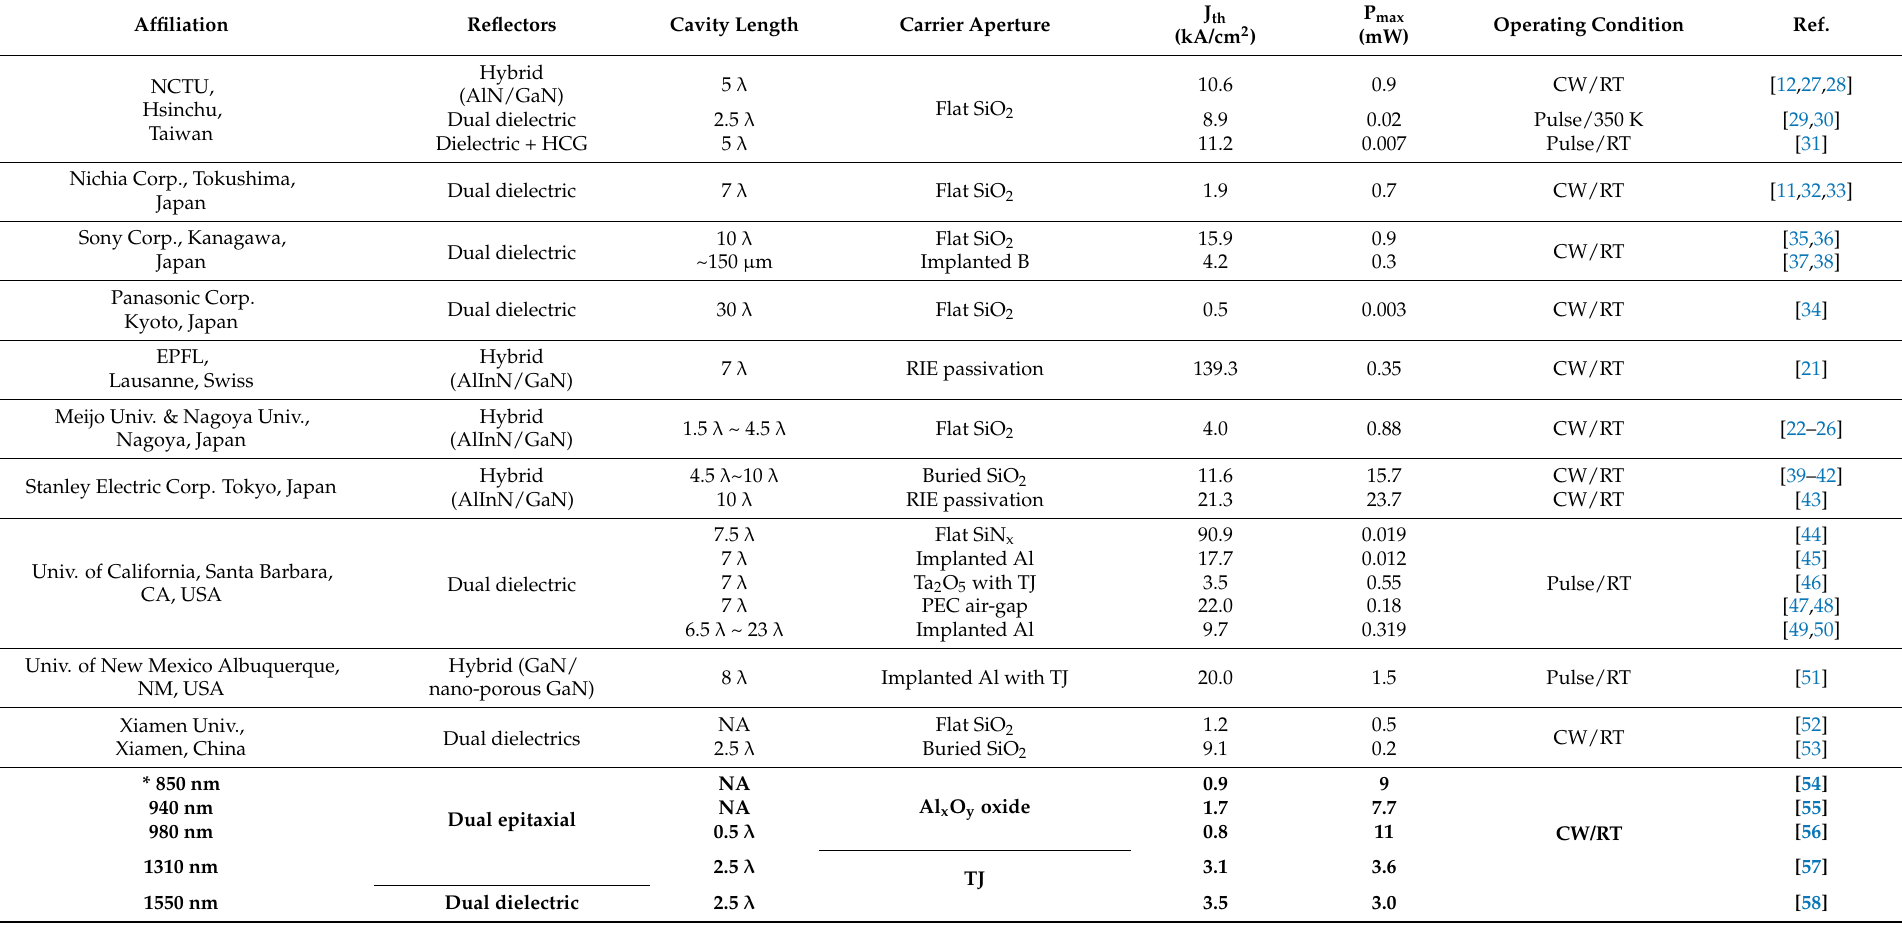
Table 2. Structure and device summary of blue VCSEL benchmarks of Figure 2. In the “Reflectors” columns, “Hybrid” implied one reflector is grown epitaxially and the other is deposited dielectrics. Dual dielectric (epitaxial) means both reflectors were deposited dielectrics (epitaxial mirror). TJ in the carrier aperture column stands for tunnel junction. If the same affiliation reported different device results with the same device configuration, only the latest published result will be recorded in the table. * Representative near-IR device VCSEL results were put at the bottom of the table. For a more compact table, the spectral region is recorded in the affiliation